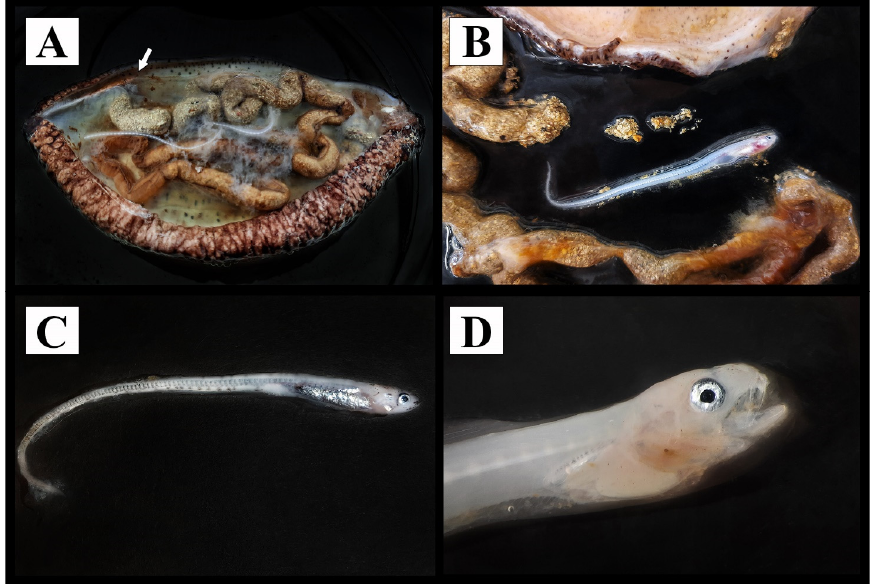
Figure 8. Ecological association between H. tubulosa and the commensal fish Carapus acus . ( A ) The larva of C. acus is visible in the body cavity of the sea cucumber, with the small head of the fish and its eye highlighted by a white arrow. ( B ) C. acus after dissection of the H. tubulosa specimen. ( C ) An adult of C. acus extracted from a H. tubulosa collected in “Grotta verde”, SZ 3. ( D ) Detail of the cephalic portion of the commensal fish.